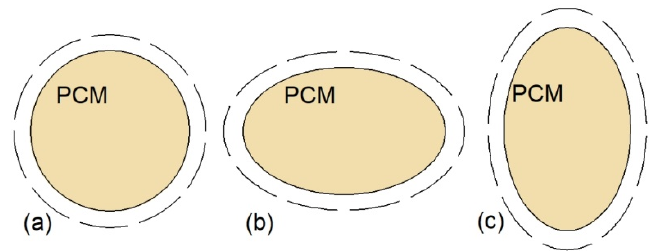
Figure 7. Cross-sections of the cylinder model DTHX: ( a ) Circular inner tube, ( b ) horizontal ellipse inner tube, ( c ) vertical ellipse inner tube [77].